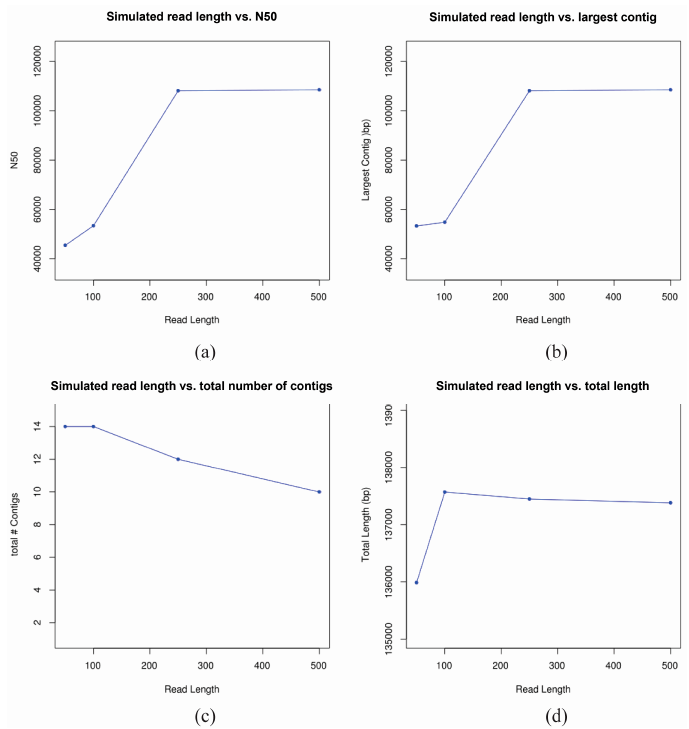
Figure 4. Effect of read length on de novo assembly metrics. De novo assemblies were generated using simulated reads of four different lengths (50, 100, 250 and 500 bp) and evaluated using QUAST. The effect of read length is shown for: ( a ) N50, ( b ) the largest contig, ( c ) the total number of contigs, and ( d ) the total length of the assembly. After 250 bp, the gain from longer read lengths levels off.